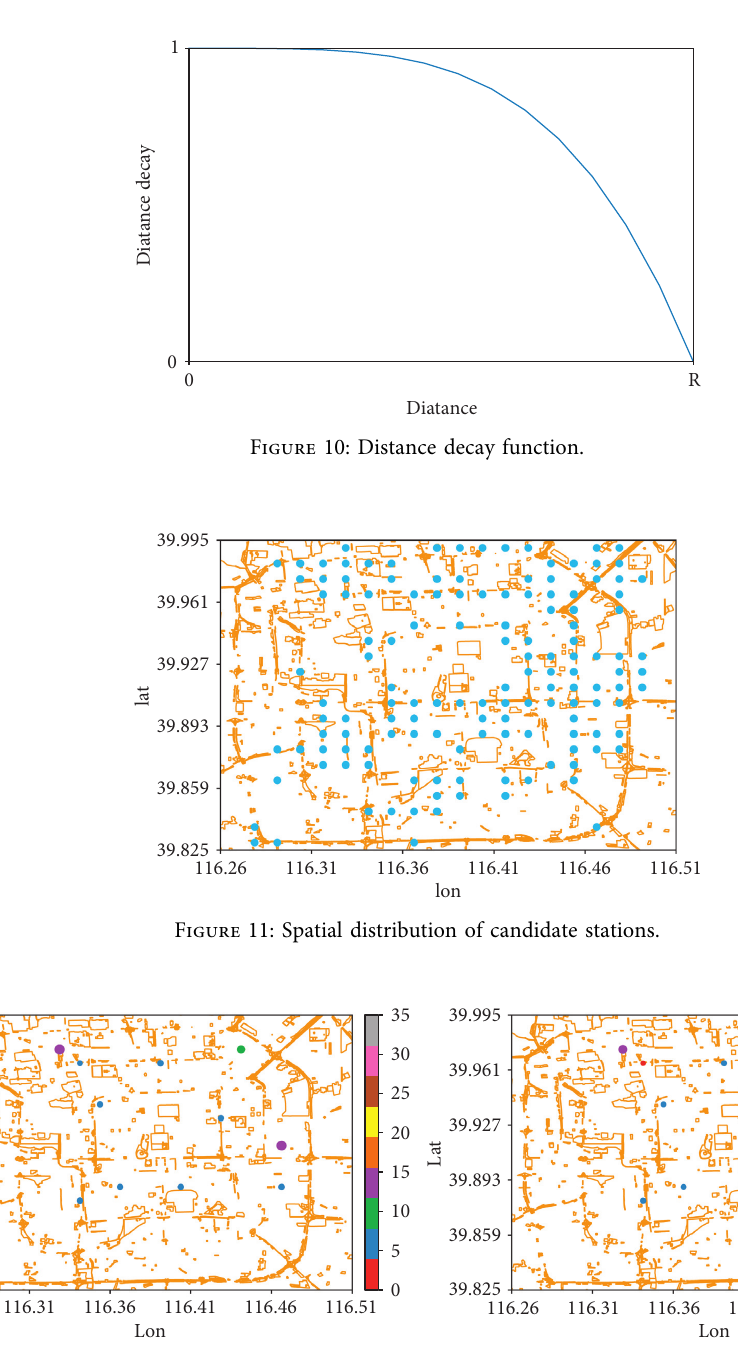
Figure 12: Parking spots and vehicle distribution when rate �